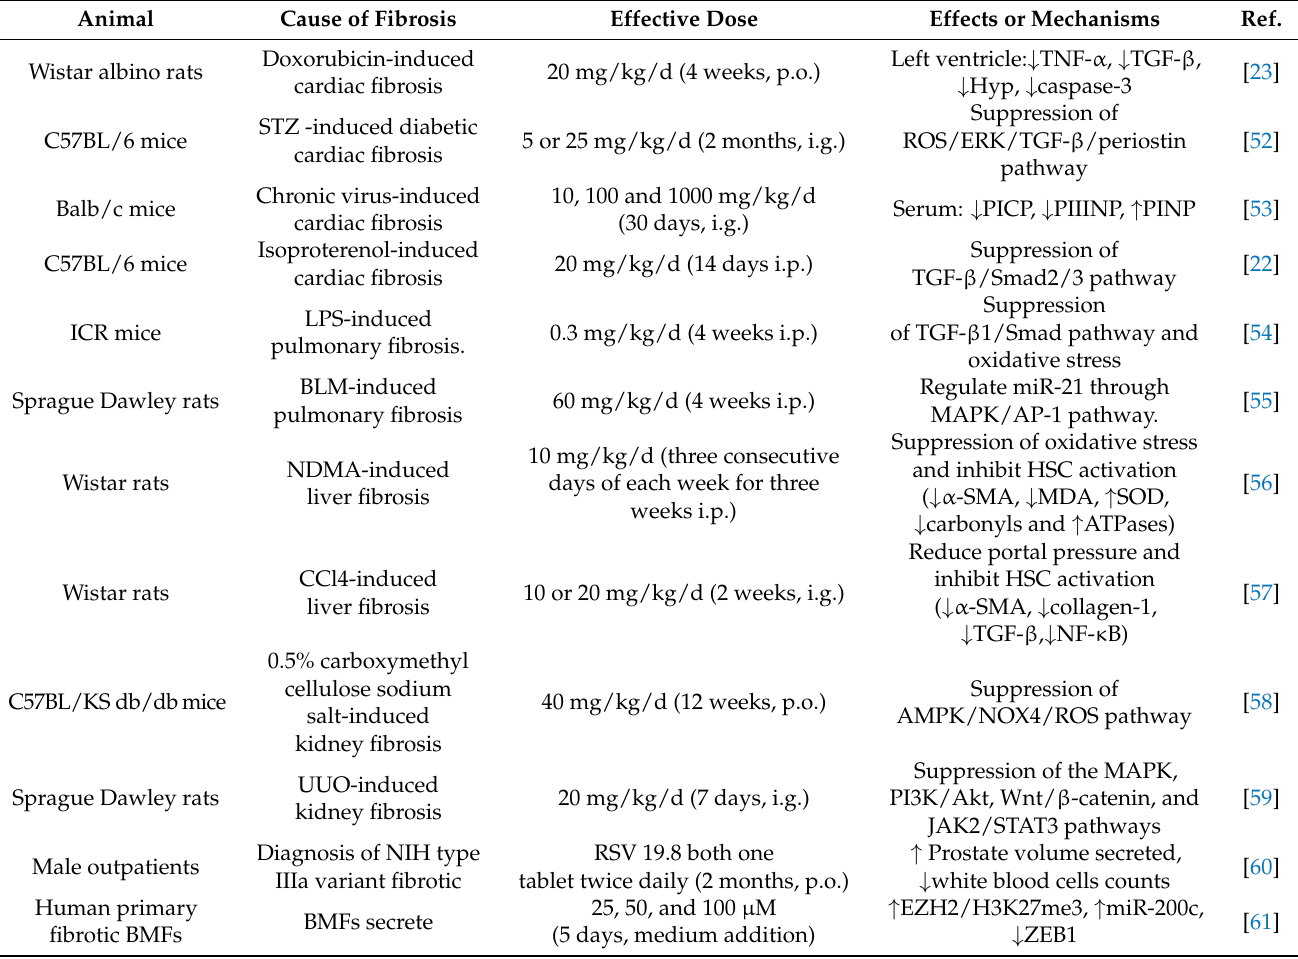
Table 1. Effects of resveratrol on different types of fibrosis ( ↓ : a decrease; ↑ : an increase). Animal Cause of Fibrosis Effective Dose Effects or Mechanisms Ref. Wistar albino